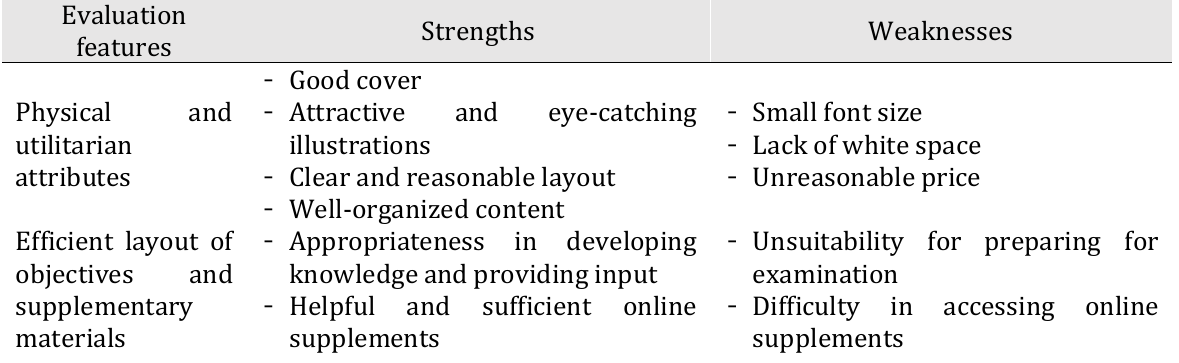
Table 7. Summary of the